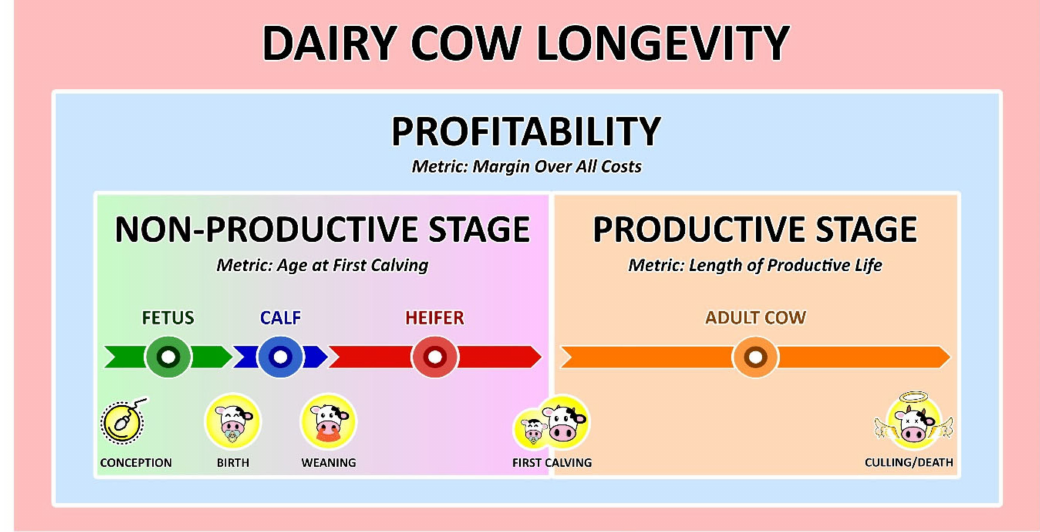
Figure 6. Relationship between the concepts of profitability, non-productive and productive life stages of dairy cows for a more comprehensive definition of cow longevity along with proposed metrics representing each respective